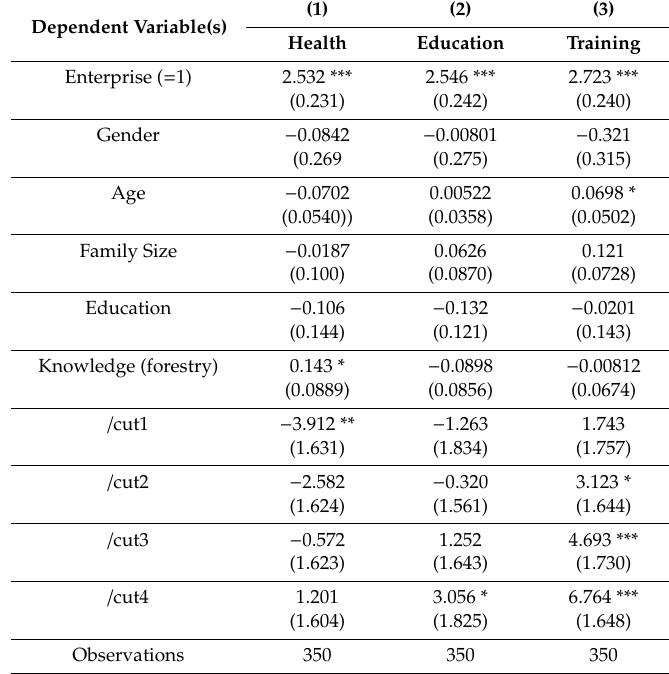
Table 5. BTAP and human